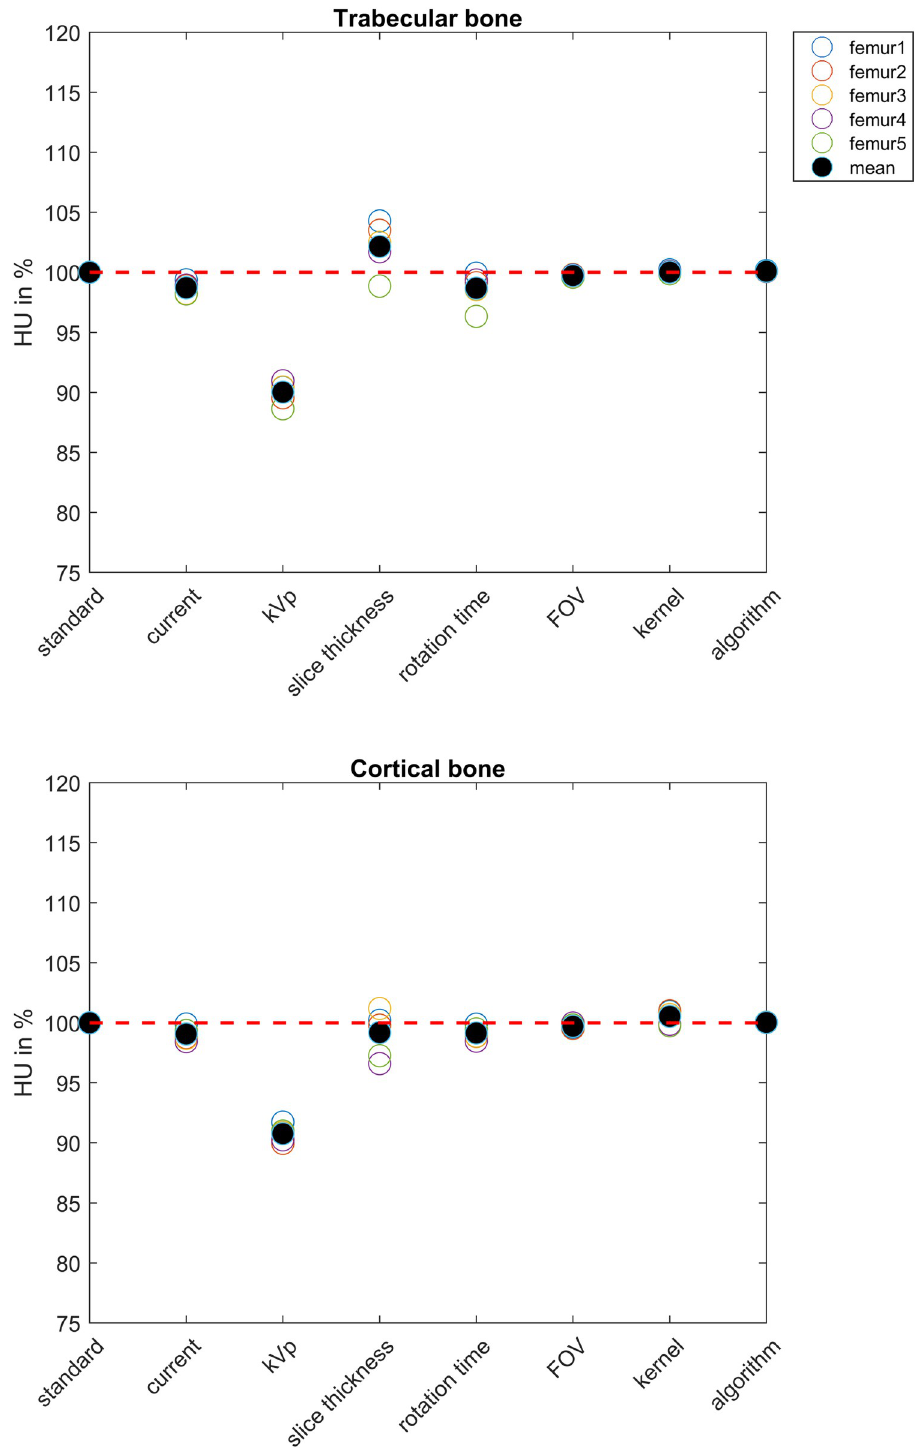
Fig 4. HU of the trabecular (upper figure) and cortical (lower figure) ROIs. For each femur, the HUs are displayed relative to the standard protocol. The red dashed line indicates 100%.